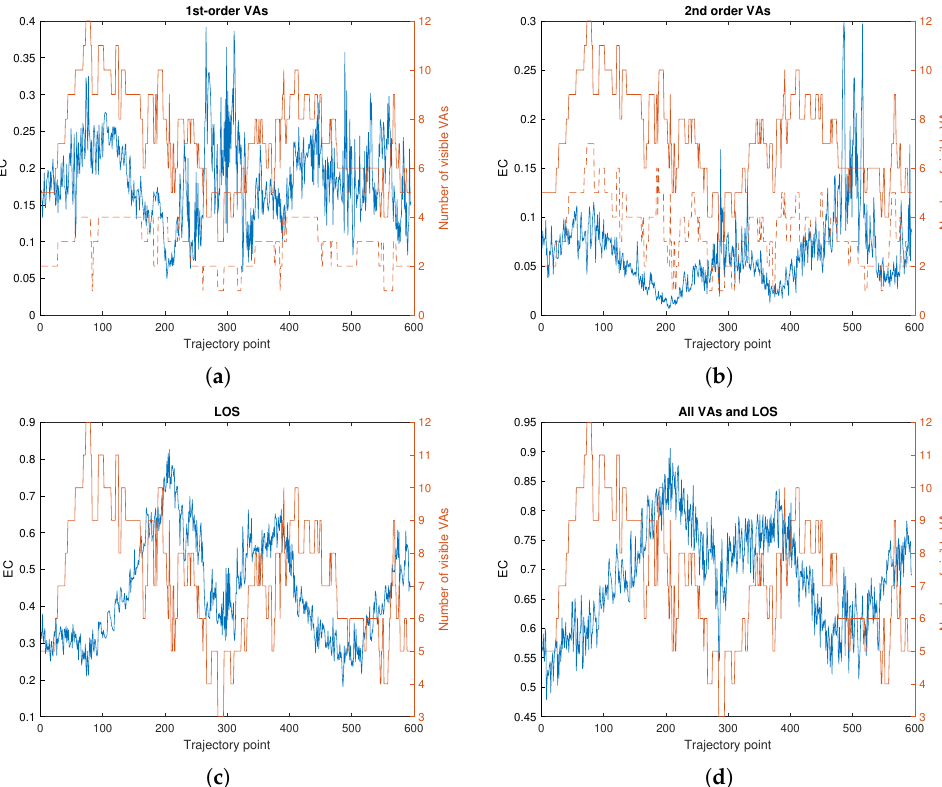
Figure 5. EC of certain SMCs vs. number of VAs visible: ( a ) first-order VAs only, ( b ) second-order VAs only, ( c ) LOS (PA) only, ( d ) all VAs and LOS (PA). The brown solid line shows the number of VAs that are visible from the corresponding trajectory point. The dashed brown line shows the number of visible VAs that are within the set of ( a ) first-order VAs or ( b ) second-order